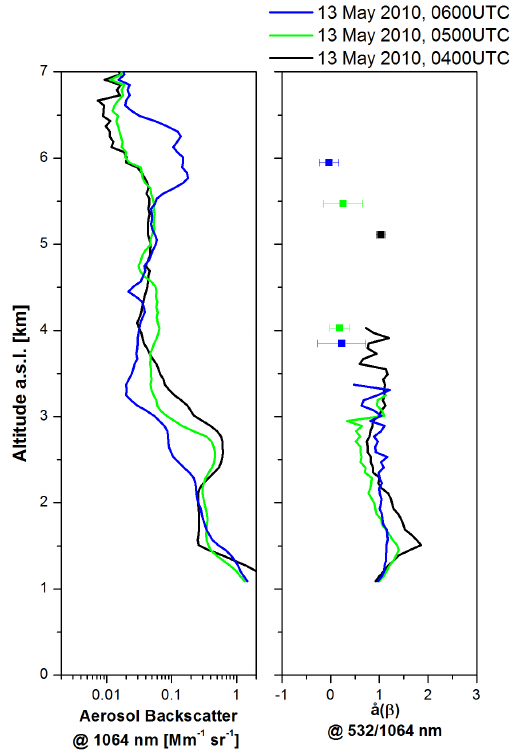
Fig. 3. Profiles of the aerosol backscatter at 1064nm and of the backscatter related ˚Angstr¨om exponent at 532/1064nm measured on 13 May, at 04:00, 05:00 and 06:00UTC. Mean values are re- ported as squares for backscatter related ˚Angstr¨om exponent at alti- tude levels where statistical errors are larger than 30%. Error bars correspond to the standard errors for the mean